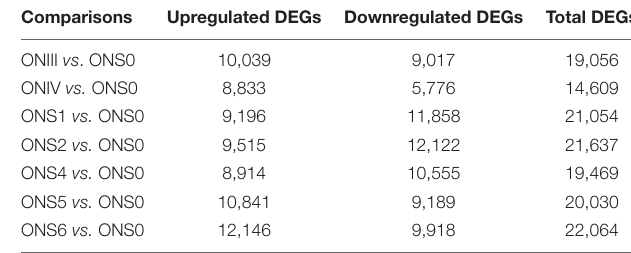
TABLE 1 | The numbers of differentially expressed genes (DEGs, Log 2 FC > 1.58 and FDR < 0.01) throughout ‘O’Neal’ flower bud and fruit development for each